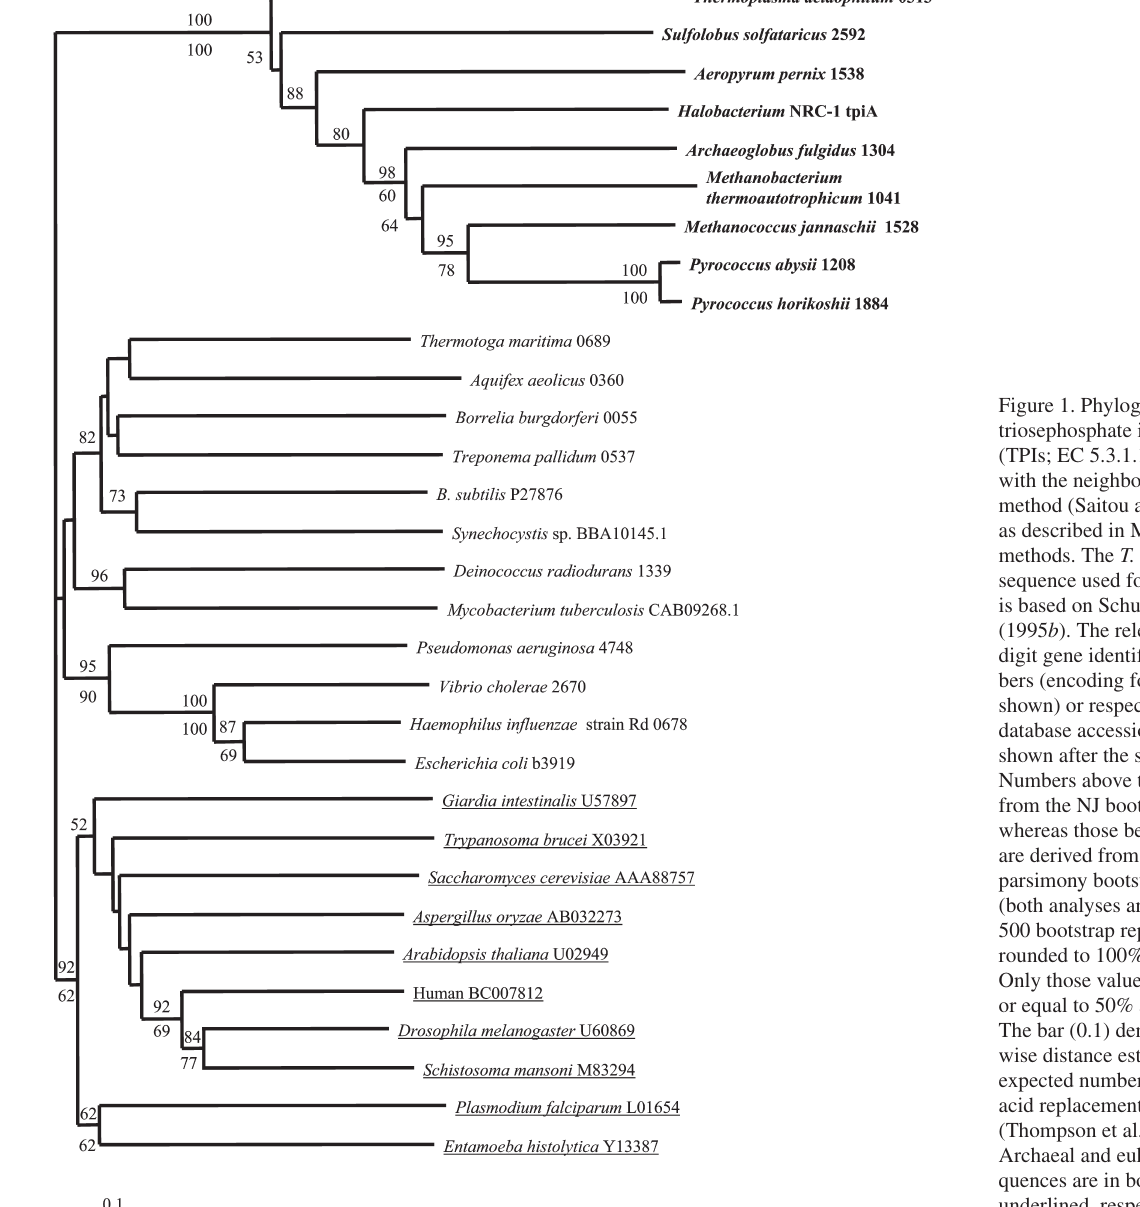
ARCHAEA ONLINE at http://archaea.ws